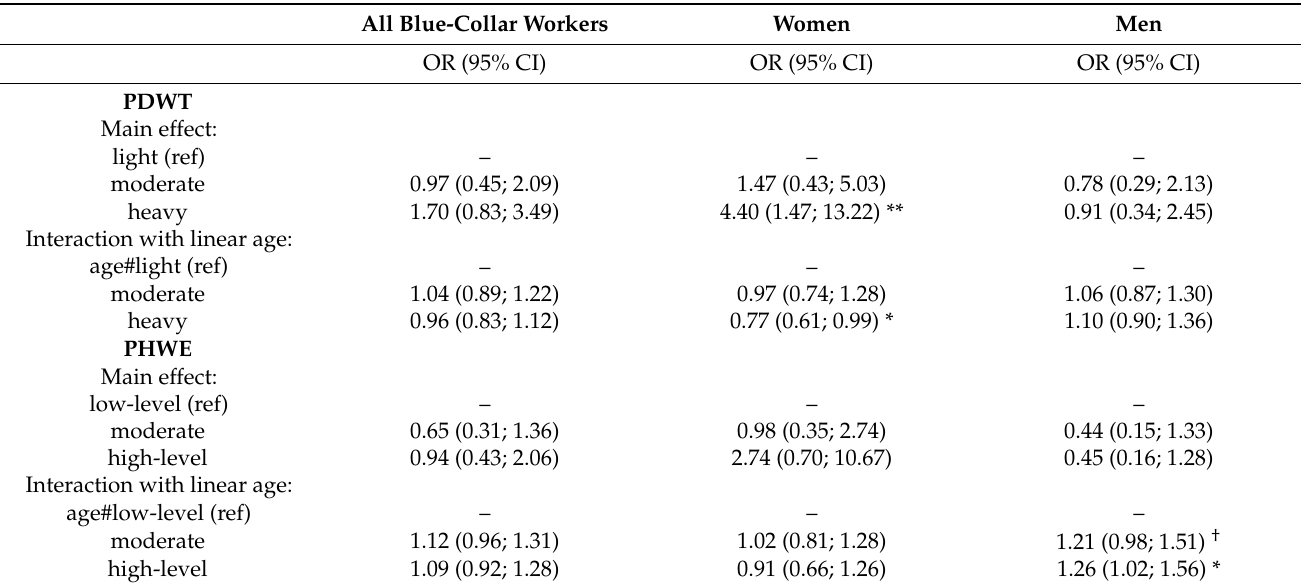
Table 3. Blue-collar workers. Moderating effect of linear age (limited to <68 years at baseline wave) on the association between PDWT or PHWE and retired (vs. still in work) two years later (age * PDWT/PHWE). Odds ratio (OR) and 95% confidence interval (CI) presented. Separate models for PDWT and